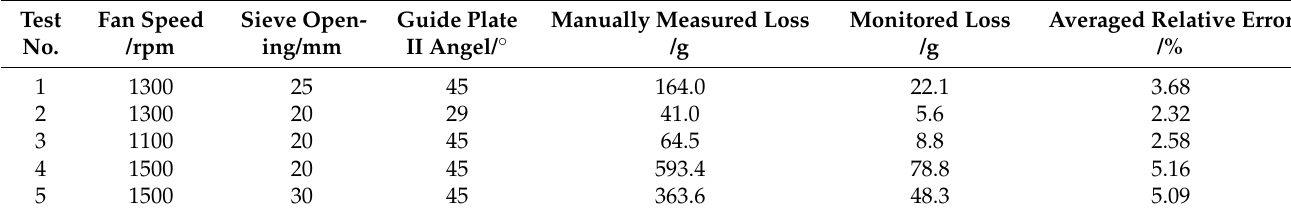
Table 8. Grain loss monitoring accuracy under different working